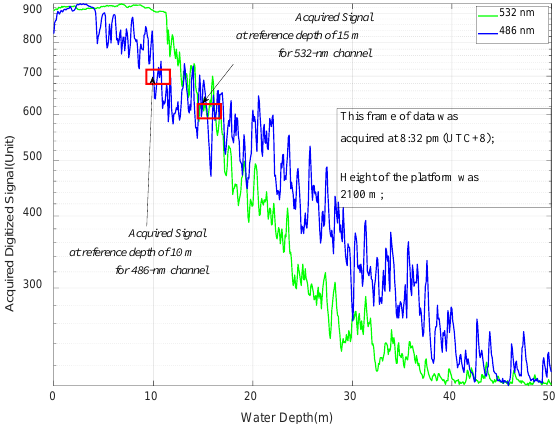
Figure 9. Selection of reference depths for the 532 and 486 nm channels.